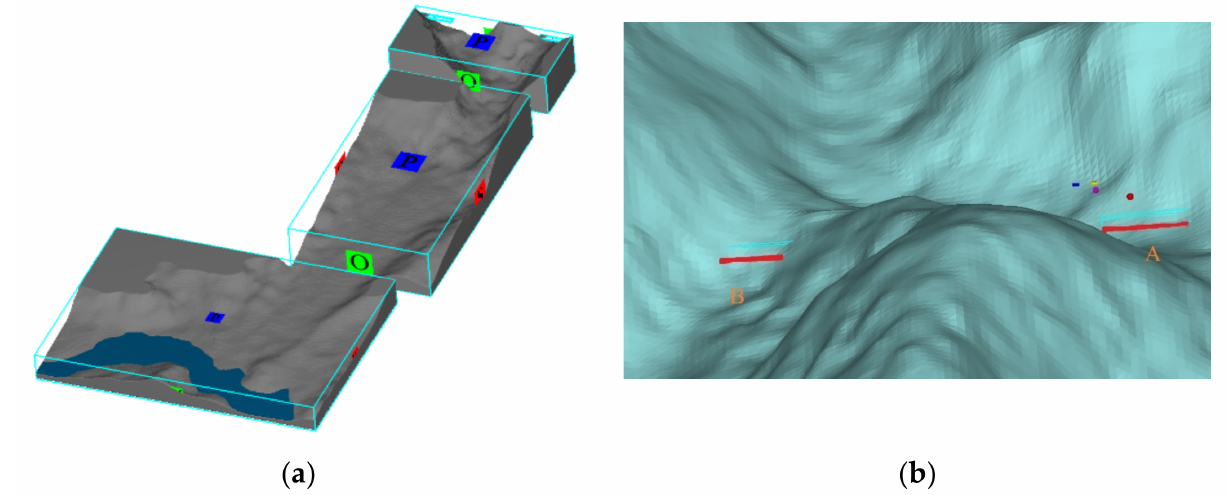
Figure 5. ( a ) Meshing range of the simulation; ( b ) schematic diagram of debris flow inlet, as shown in the red area.